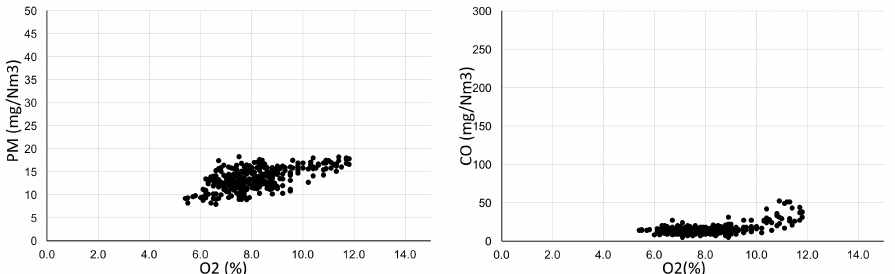
Figure 6. PM–O 2 correlation with very low CO level ( left ); CO–O 2 correlation with very low CO level ( right ). CO and PM are referred at O 2 13%. Data plotted are the instantaneous values collected during testB2–3.1.